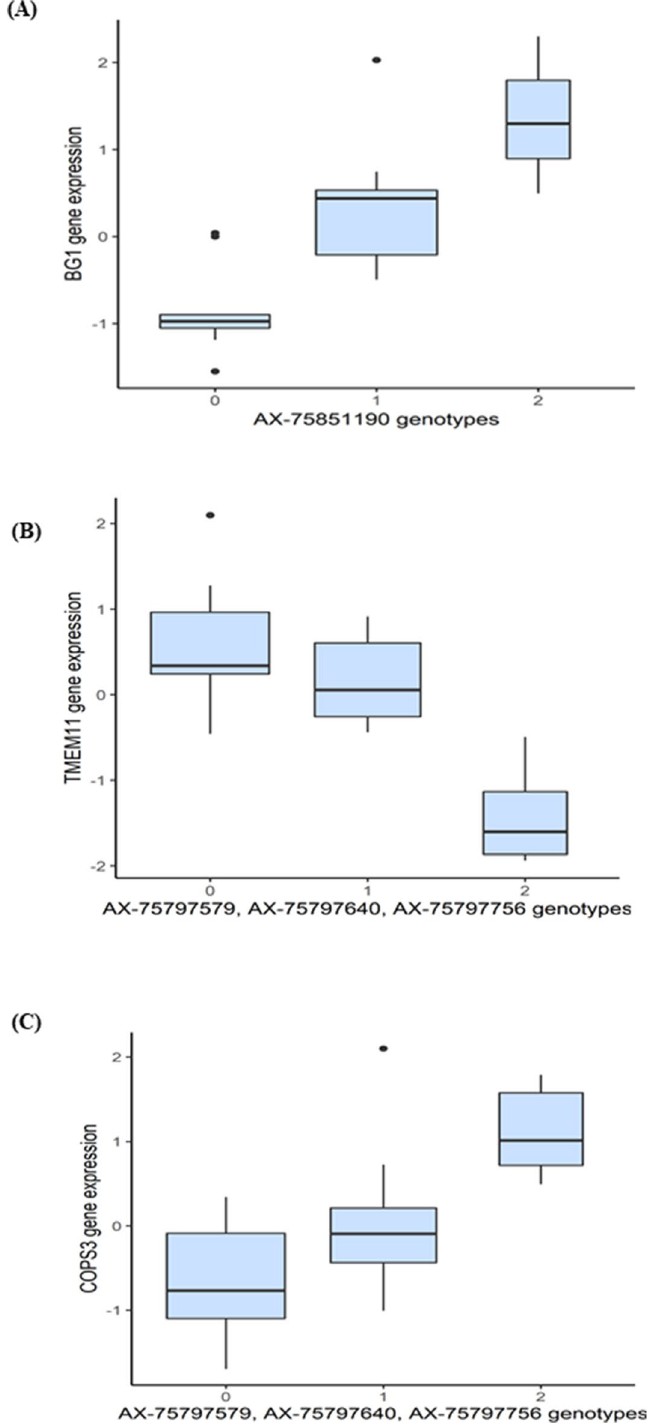
Figure 3. Expression QTL analysis results. Boxplots showing the expression of BG1 (4A), TMEM11 (4B) and COPS3 (4C) genes depending on the genotypes of SNPs acting as cis-elements. On the x-axis, "0", "1" and "2" represent the number of copies of the non-reference allele, and on the y-axis the expression of each gene (in Transcripts Per Million, TPM), is represented after mean-centering and